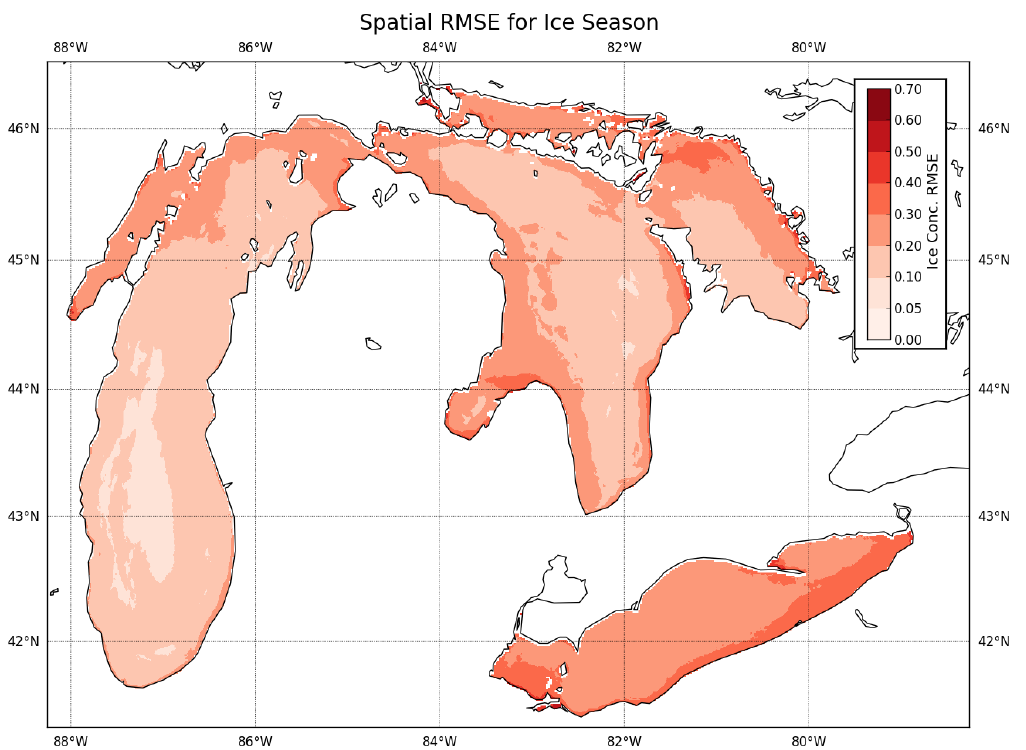
Figure 11. Spatial distribution of ice concentration RMSE averaged throughout the entire ice season for all simulated years.